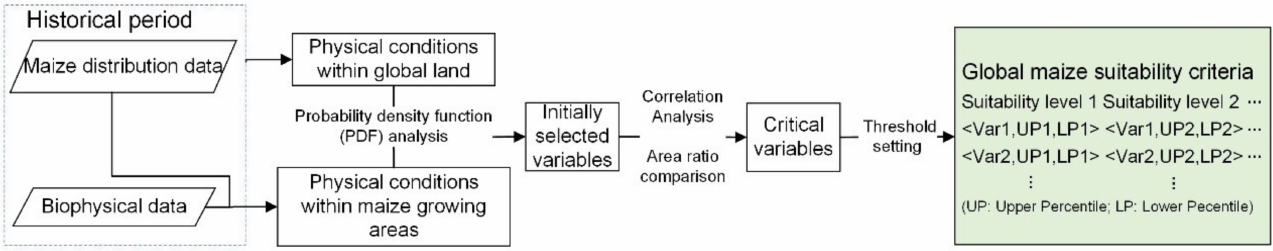
Figure 2. Designing the criteria for the assessment of land as suitable for growing